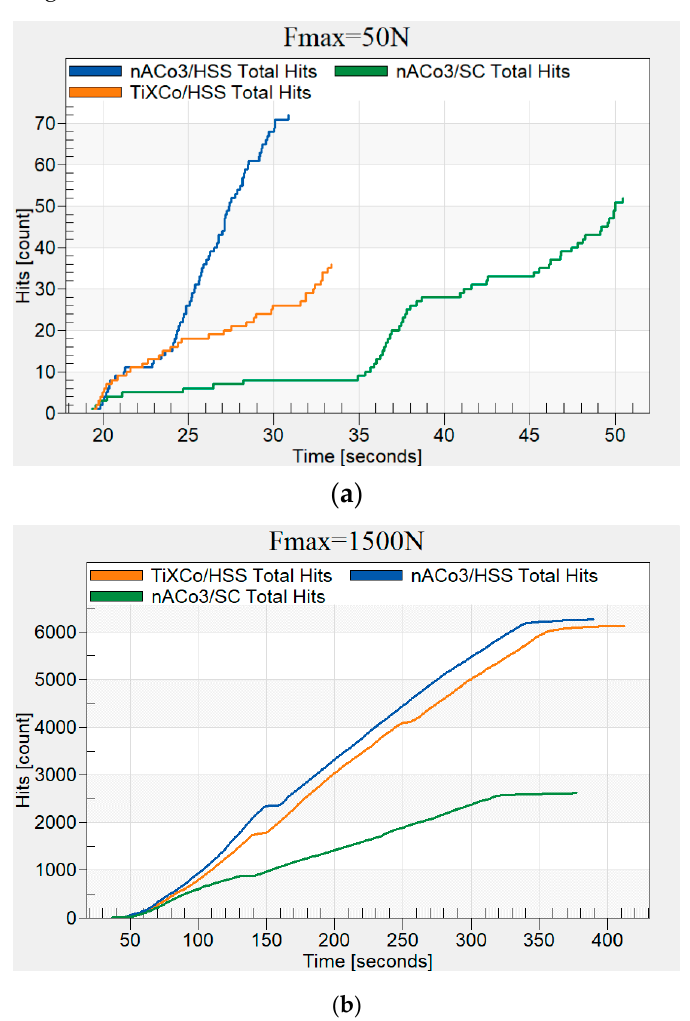
Figure 8 documents the results from the macroindentation test with the data recorded using AE.